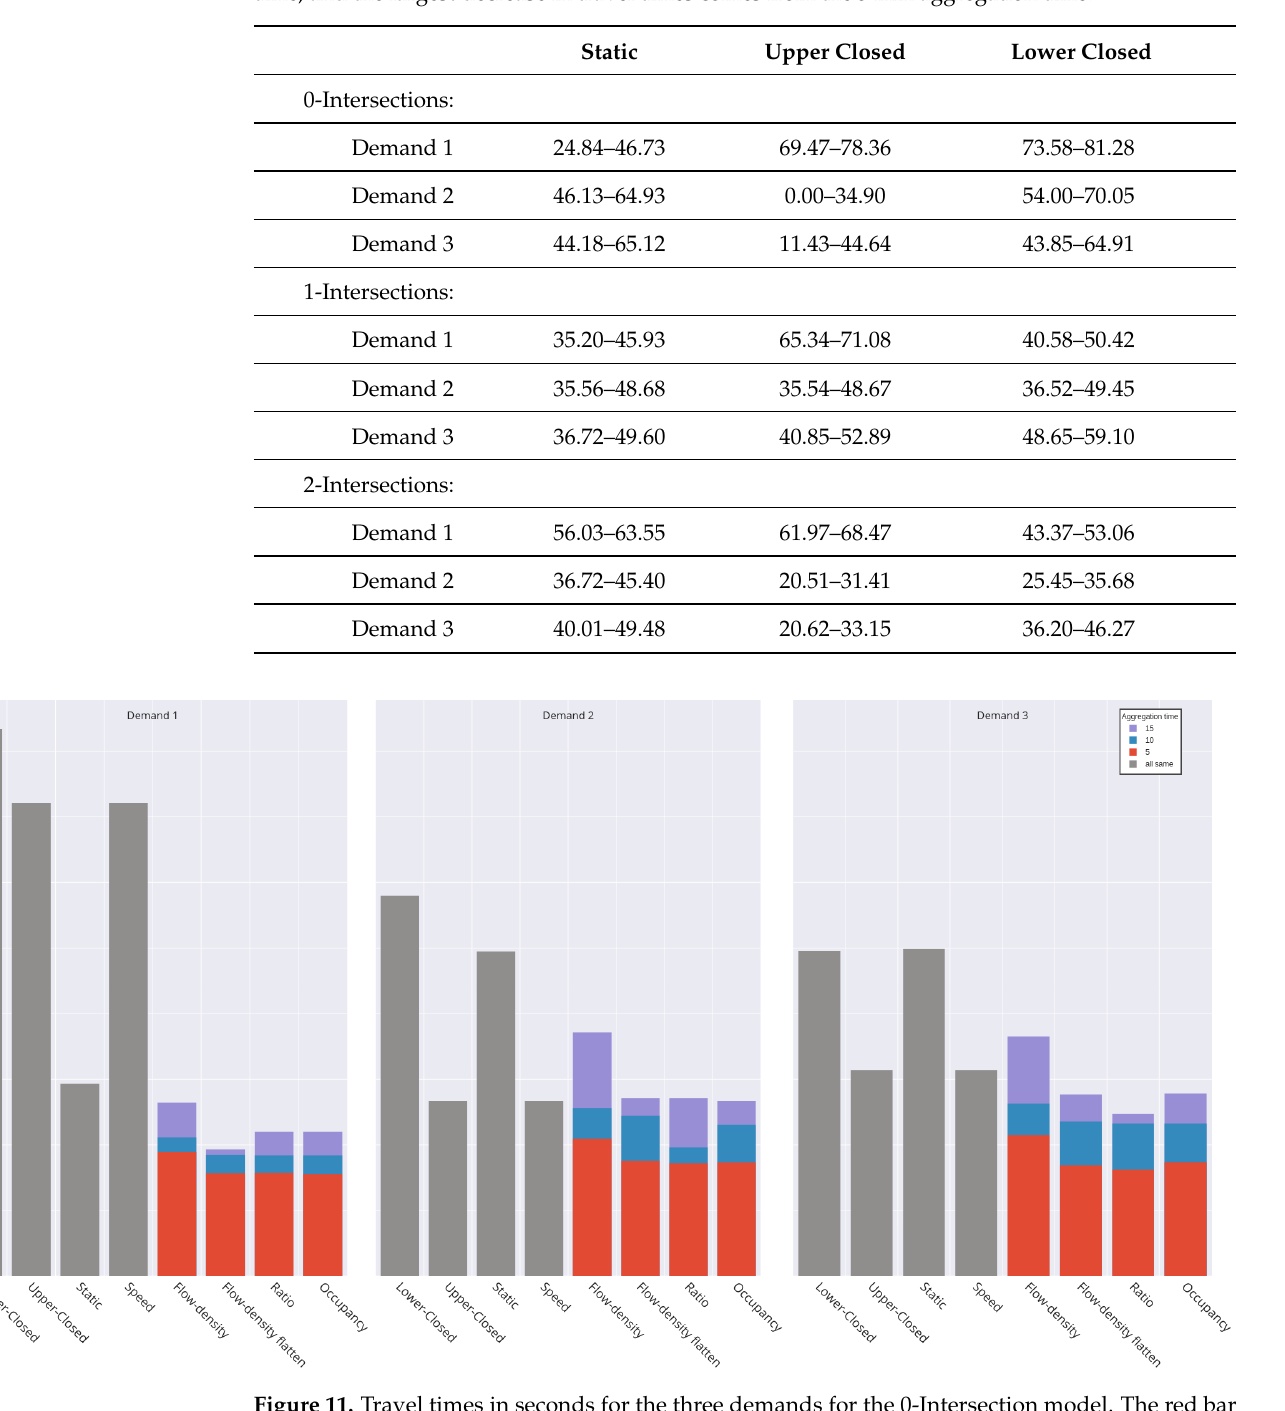
Figure 11. Travel times in seconds for the three demands for the 0-Intersection model. The red bar chart represents the 5 min aggregation time, the blue one represents the 10 min aggregation time, and the purple one represents the 15 min aggregation time. They are placed on top of each other to demonstrate the difference in aggregation times. The grey bars represent the base cases (no algorithm applied) as well as the speed algorithm, since it performed consistently across all test situations. Each demand is shown in its own bar chart, allowing them to be